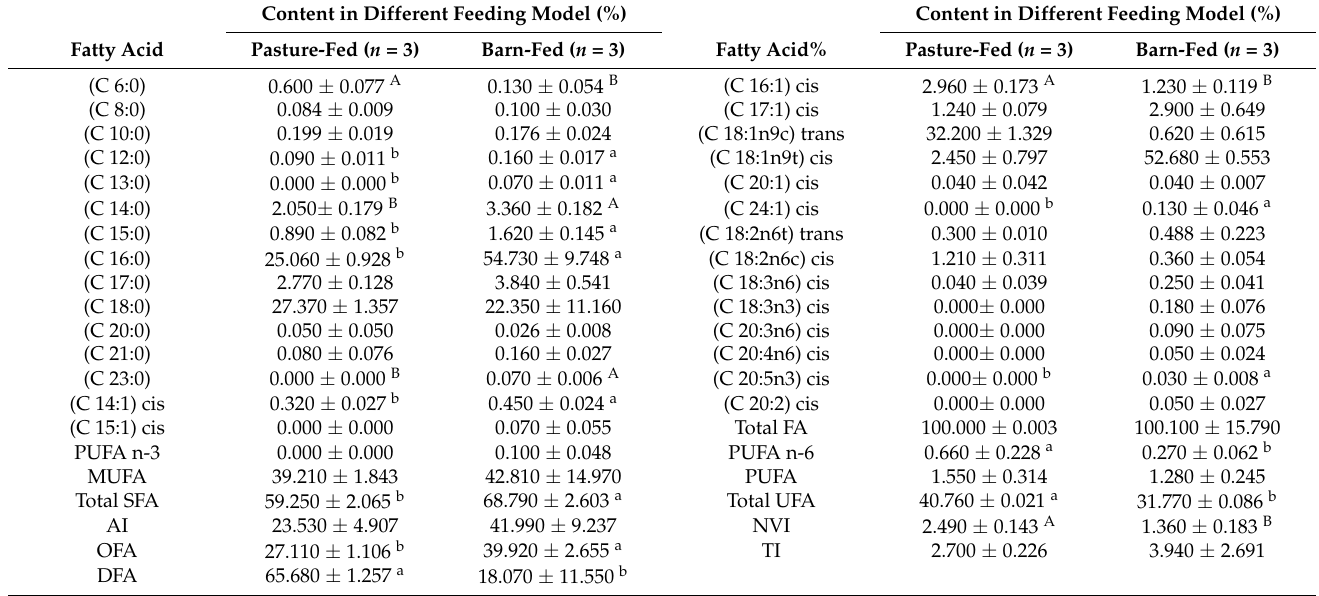
Table 1. Fatty acid analysis of the longissimus lumborum from pasture-fed and barn-fed goats. Content in Different Feeding Model (%) Content in Different Feeding Model